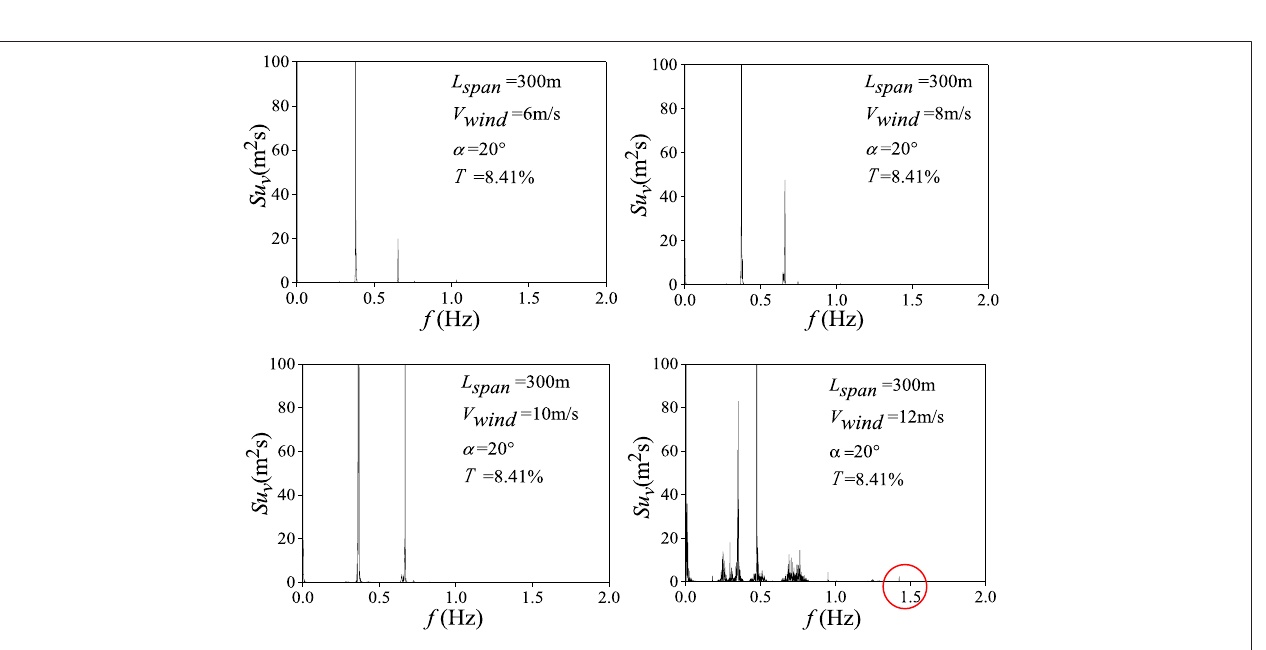
Frontiers in Energy Research |